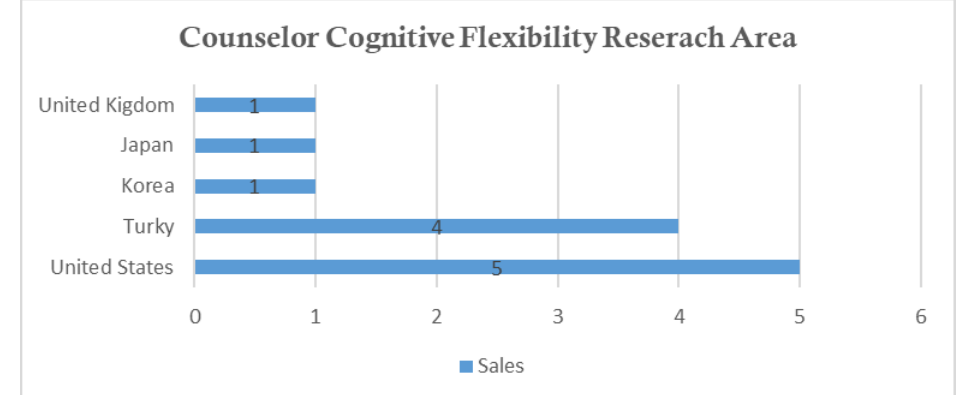
Fig 2. Research Area of Research Sample Paper